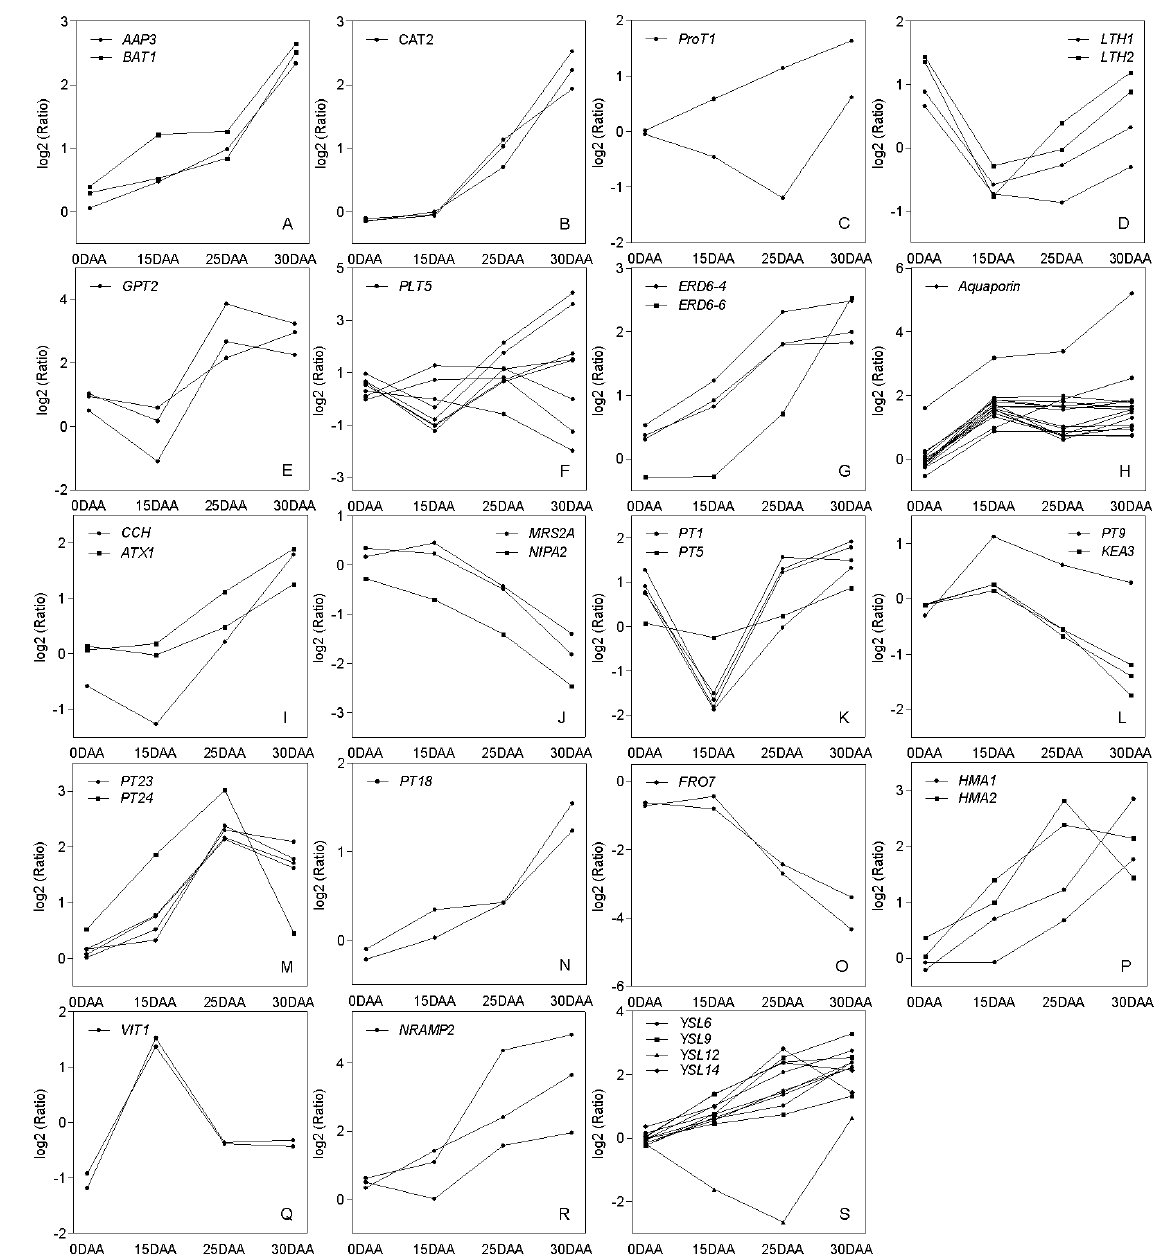
Figure 3. Expression trends of differentially expressed transporter genes. ( A – D ) Amino acid transporter genes. ( E – G ) Carbohydrate transporter genes. ( H ) Aquaporin transporter genes. ( I ) Cu transporter genes. ( J ) Mg transporter genes. ( K – N ) K transporter genes. ( O – S ) Fe and Zn transporter genes.